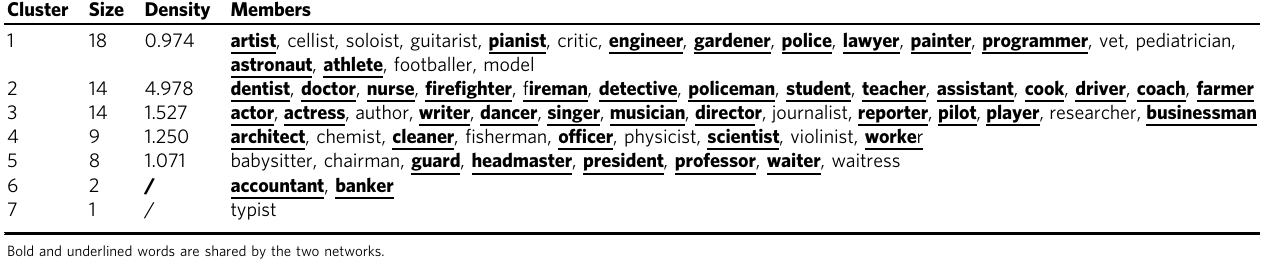
Bold and underlined words are shared by the two